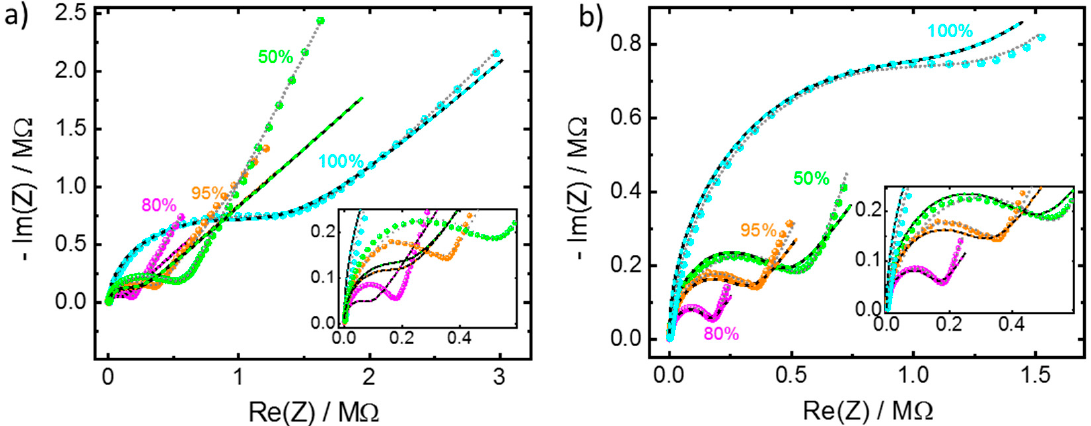
Figure A2. Nyquist plots for the IL@HKUST-1 in the form of a MOF-pellet sandwiched between 2 gold electrodes, see Figure 3b. The experimental data are shown as spheres, the grey-dotted lines are the fits with the ( R-CPE dl ) ‖ CPE geo circuit (same data as in Figure 3b). The black-color-dashed lines are the best fits by Randles equivalent circuit. The IL pore fillings are 50%, 80%, 95%, and 100%, as indicated. The frequency range in panel ( a ) is 100 Hz to 5 MHz, and in panel ( b ) is 1109 Hz to 5 MHz. Only the plotted data are used for the fitting by the models. The major reason for the poor description of the experimental data by the Randles circuit is the fact that the Warburg resistance of the Randles circuit results in a low-frequency ray with an angle of 45° in the Nyquist plots, which is often not the case in the experimental data. This results in poor fits, especially when the low-frequency range is recorded, see panel ( a ).